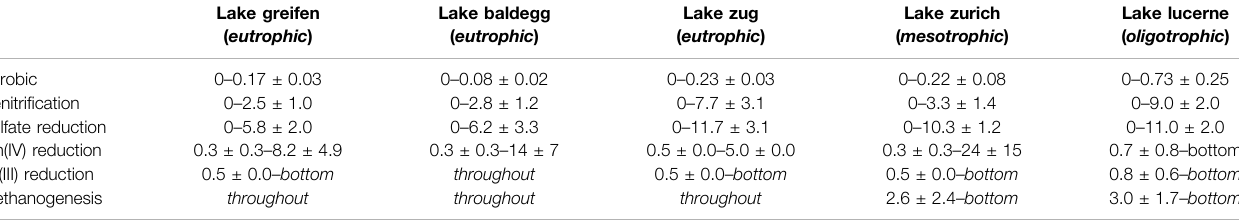
TABLE 1 | Depth intervals (in cm) of respiration reactions (average ±standard deviation of three stations) across the fi ve lakes (based on Figure 5 in Fiskal et al., 2019). Lake greifen Lake baldegg ( eutrophic ) ( eutrophic